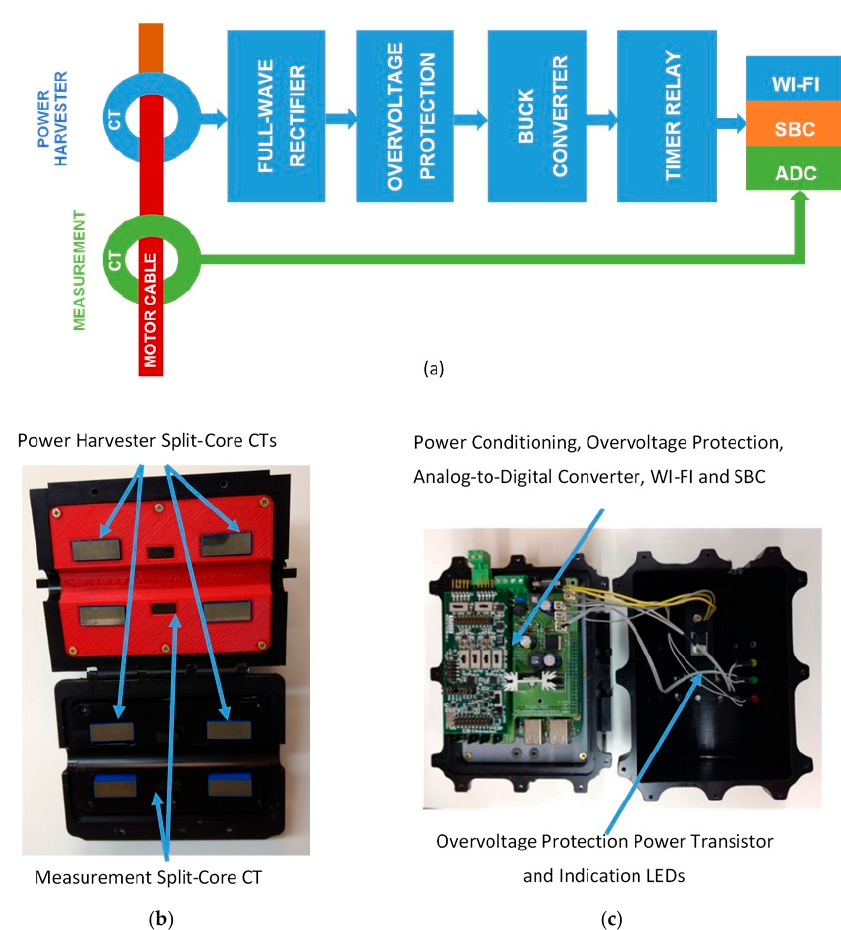
Figure 11. SSWCT: ( a ) SSWCT block diagram; ( b ) power harvester and measurement CTs the case; and ( c ) electronic circuit boards and components in the open case.